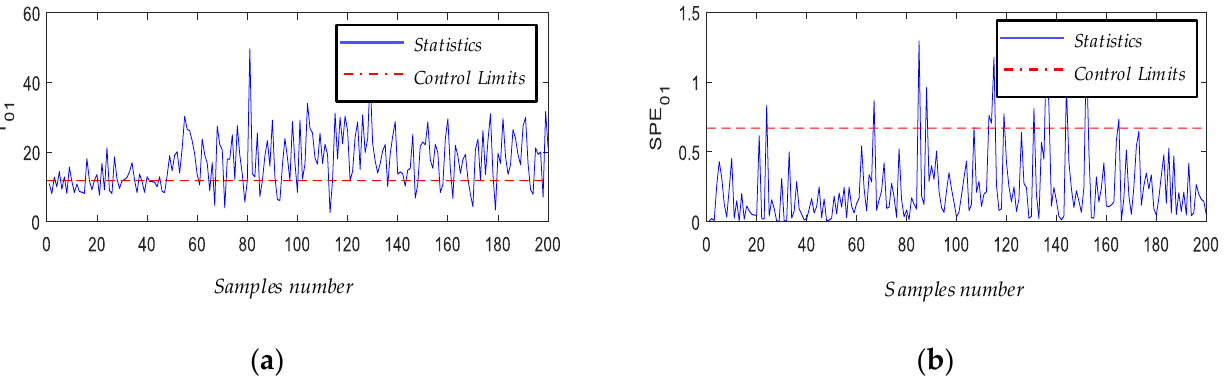
Figure 4. Experimental results of the I-PCA fault detection method for the rolling bearing rolling body: ( a ) the result of T 2 ; ( b ) the result of SPE 01